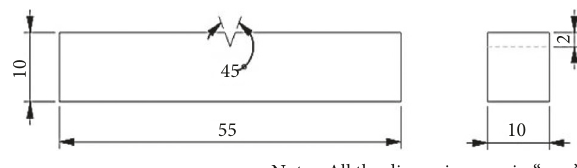
Figure 6: Dimensions of the impact toughness test